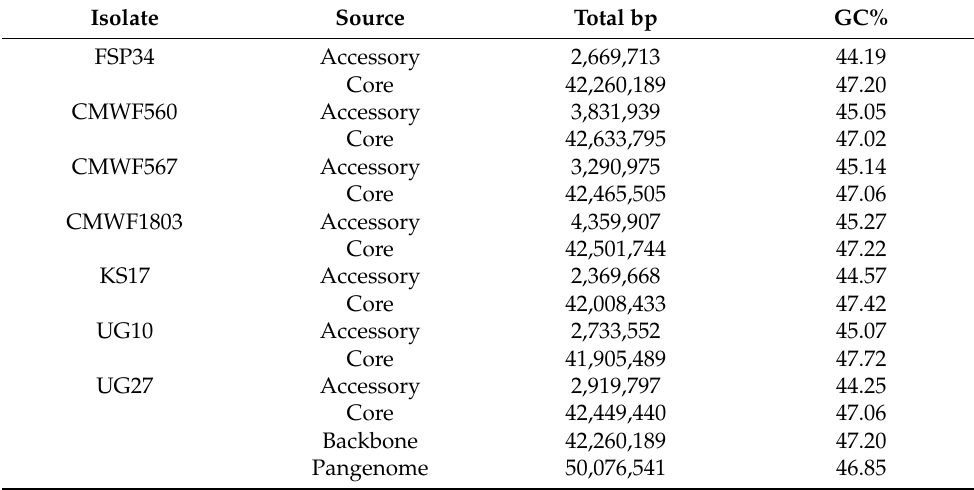
Table 7. Spine statistics showing the size of the accessory, core and pangenome elements of the F. circinatum